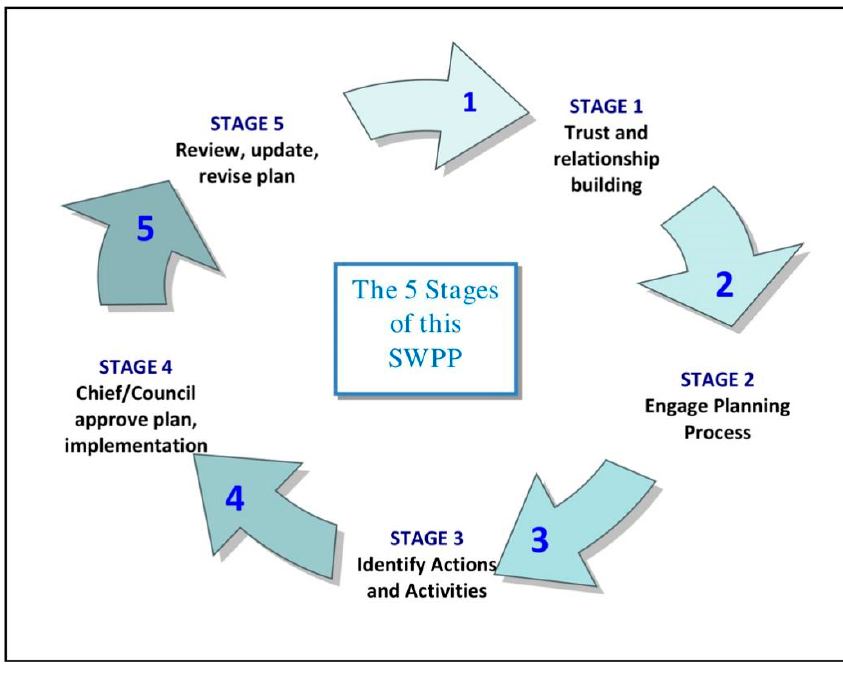
Figure 2. Planning Figure 2. Planning framework.